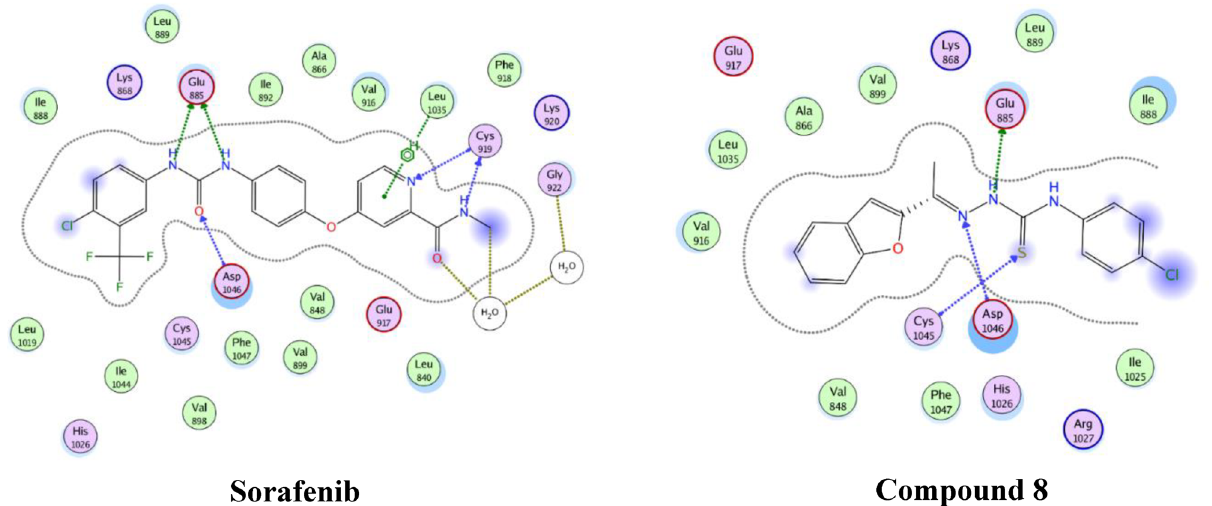
Figure 8. 2D binding mode and residues involved in the recognition of compound 8 and sorafenib against